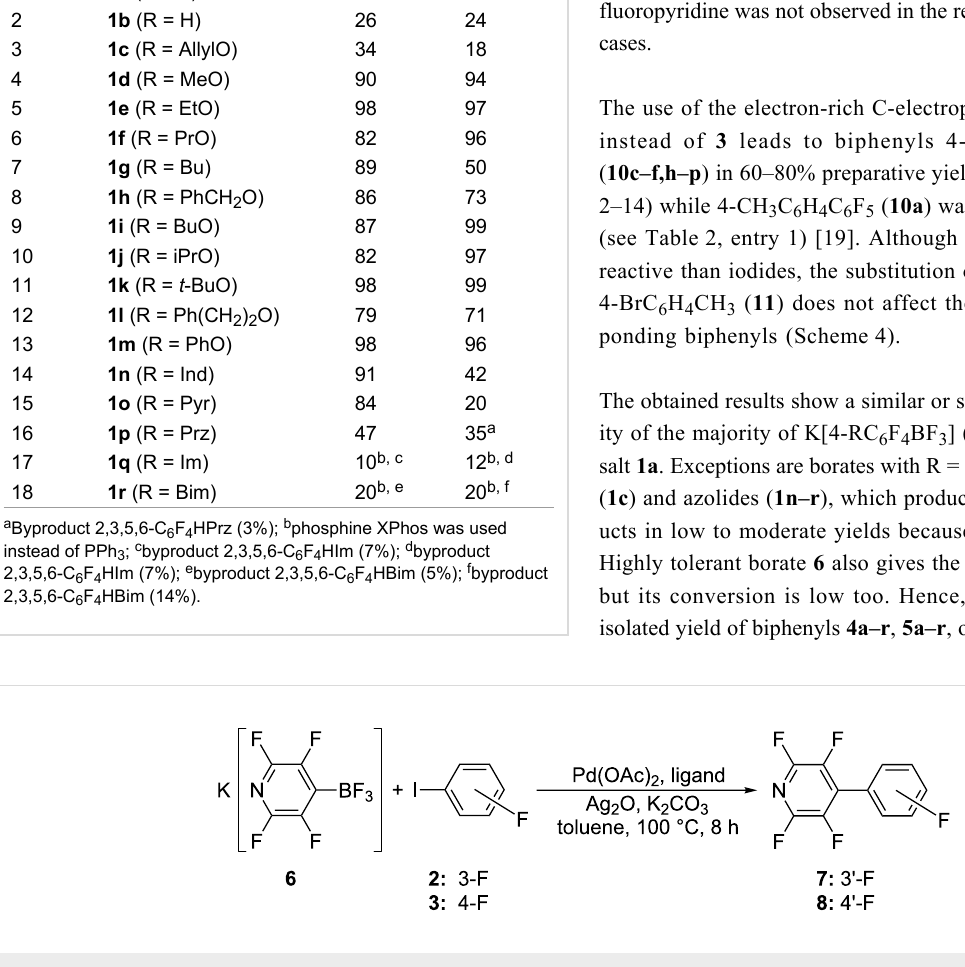
Scheme 3: Attempted synthesis of 7 (3’-F) and 8 (4’-F) by cross-coupling reaction.